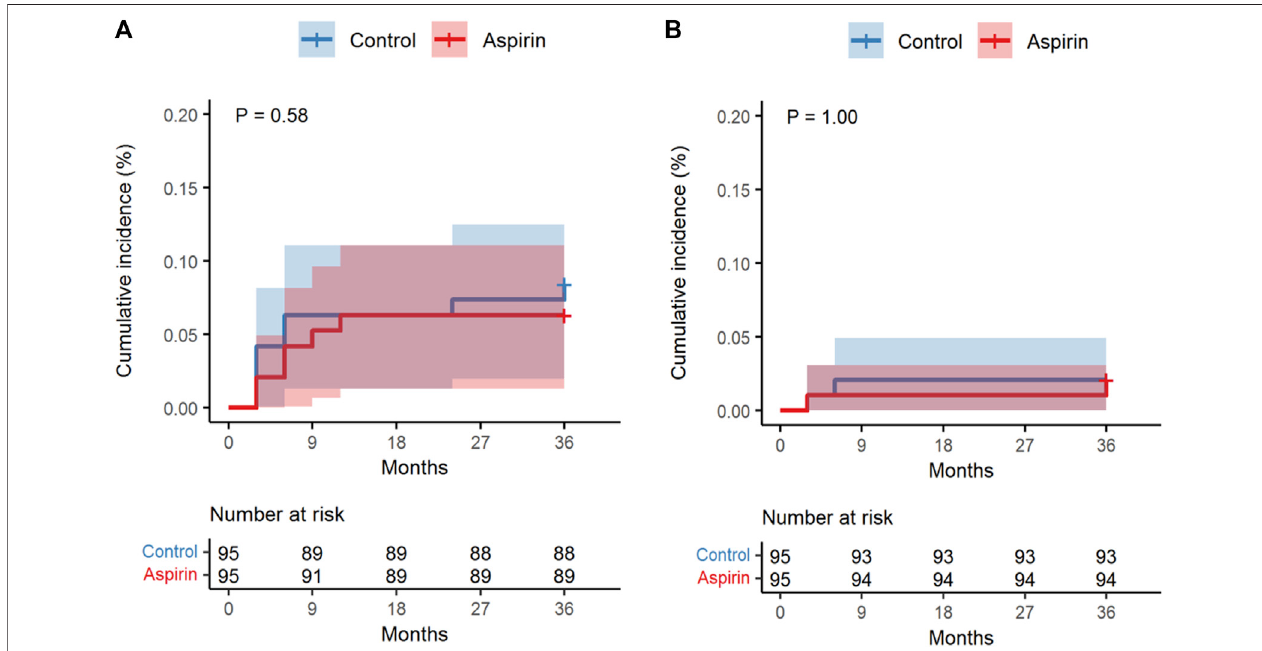
FIGURE 3 | Kaplan – Meier curve showing the cumulative incidence of ischemic complications (A) and bleeding complications (B) between the aspirin and control groups in the entire cohort.